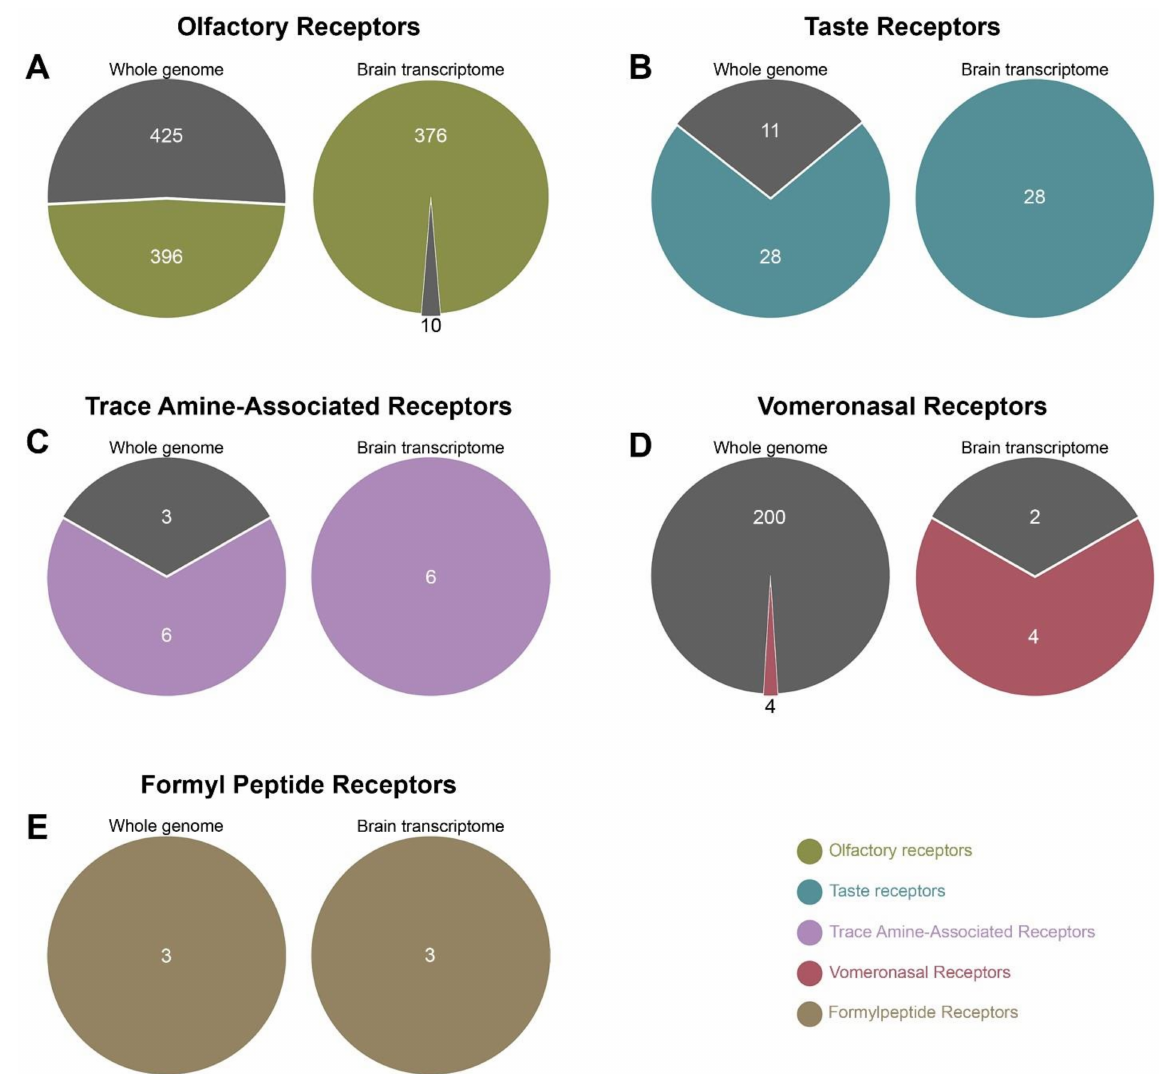
Figure 1. Genome versus transcriptome comparison of human chemoreceptors (CRs). The number of genes and pseudogenes expressed in the whole genome (left pie charts) was compared to those found to be transcribed (right pie charts), for all CR families: olfactory receptors ( A , green), taste receptors ( B , blue), trace amine-associated receptors ( C , purple), vomeronasal receptors ( D , red) and formyl peptide receptors ( E , brown), The coloured areas correspond to coding genes and dark grey areas to pseudogenes. The census of genes expressed in the brain transcriptome was carried out using data from all five subjects available in the Allen brain